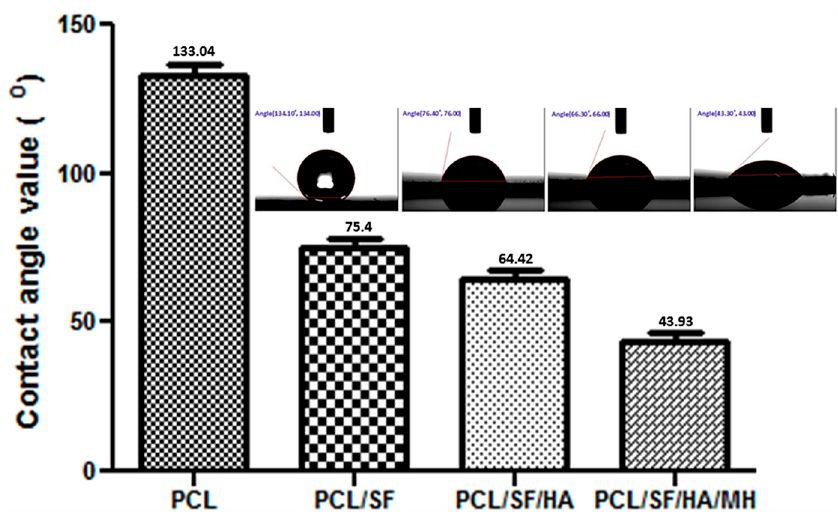
Figure 2. Water contact angle values of composite micro/nanoparticles.